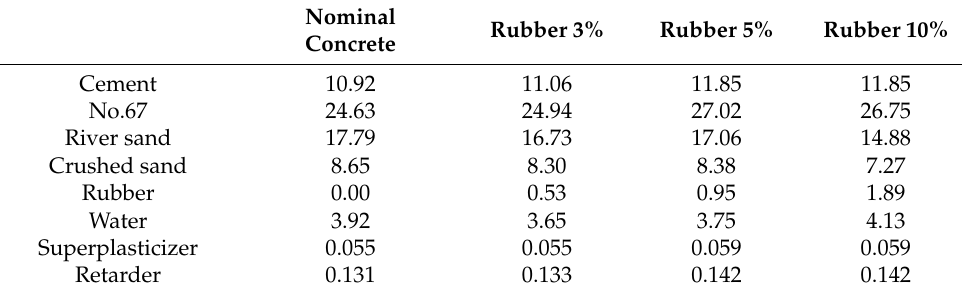
Table 2. Concrete mix design (kg for a 28 lt.